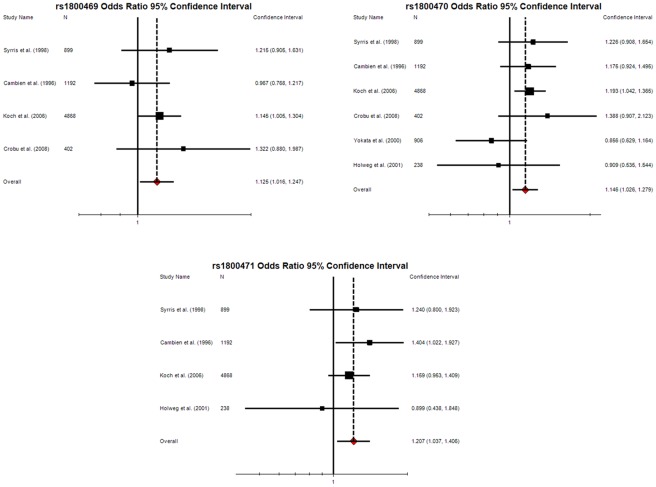
Forest plots detailing unadjusted odds ratios and 95% confidence intervals for the association between TGFβ1 rs1800469, rs1800470 and rs1800471 with end-stage CHD calculated using the dominant model of inheritance.The dotted line represents overall odds ratio calculated in the current meta-analysis for each SNP.